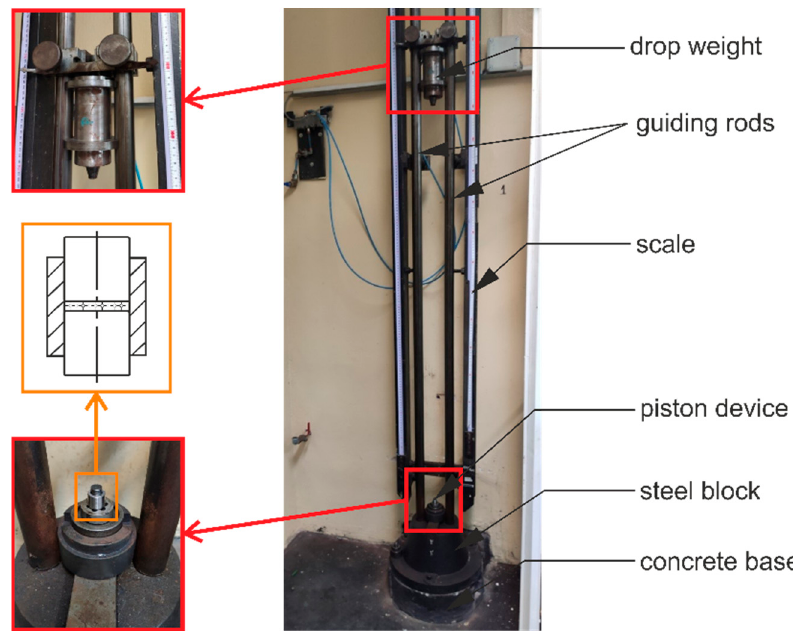
Figure 8. Scheme of the Kast fall hammer test.